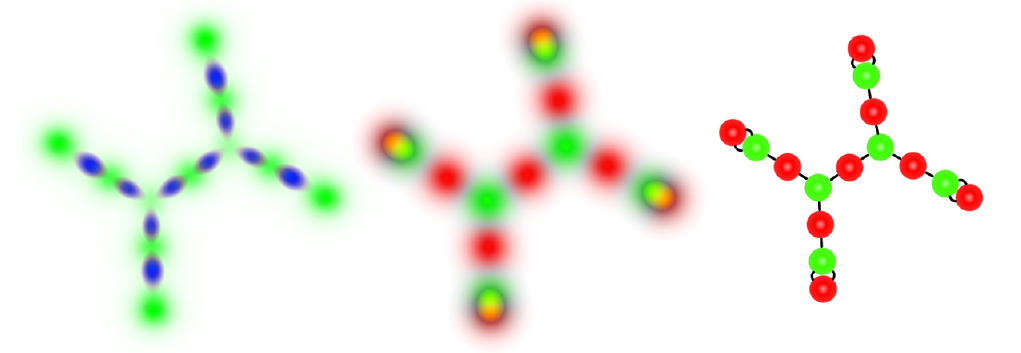
Figure 10 : ( Q 1 ; Q 2 ) = (3 ; 2) nonminimal vortex stick network. The (cid:12)gure contains 3 elements from left to right: an energy density plot, a (cid:12)eld density plot and a sketch of how the red and green vortices are interconnected. The (cid:12)rst two plots are made using the coloring scheme of (cid:12)gure